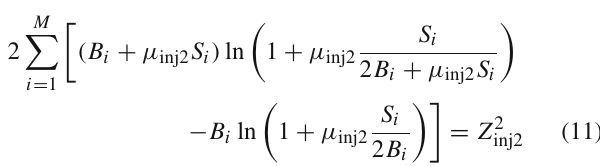
Fig. 1 The e /μ background template matrix T (top) and the Higgs LFV signal template matrix S (bottom). The x , y and z axes are the collinear mass, leading lepton p T and number of entries per bin respec- tively ( S is normalized)